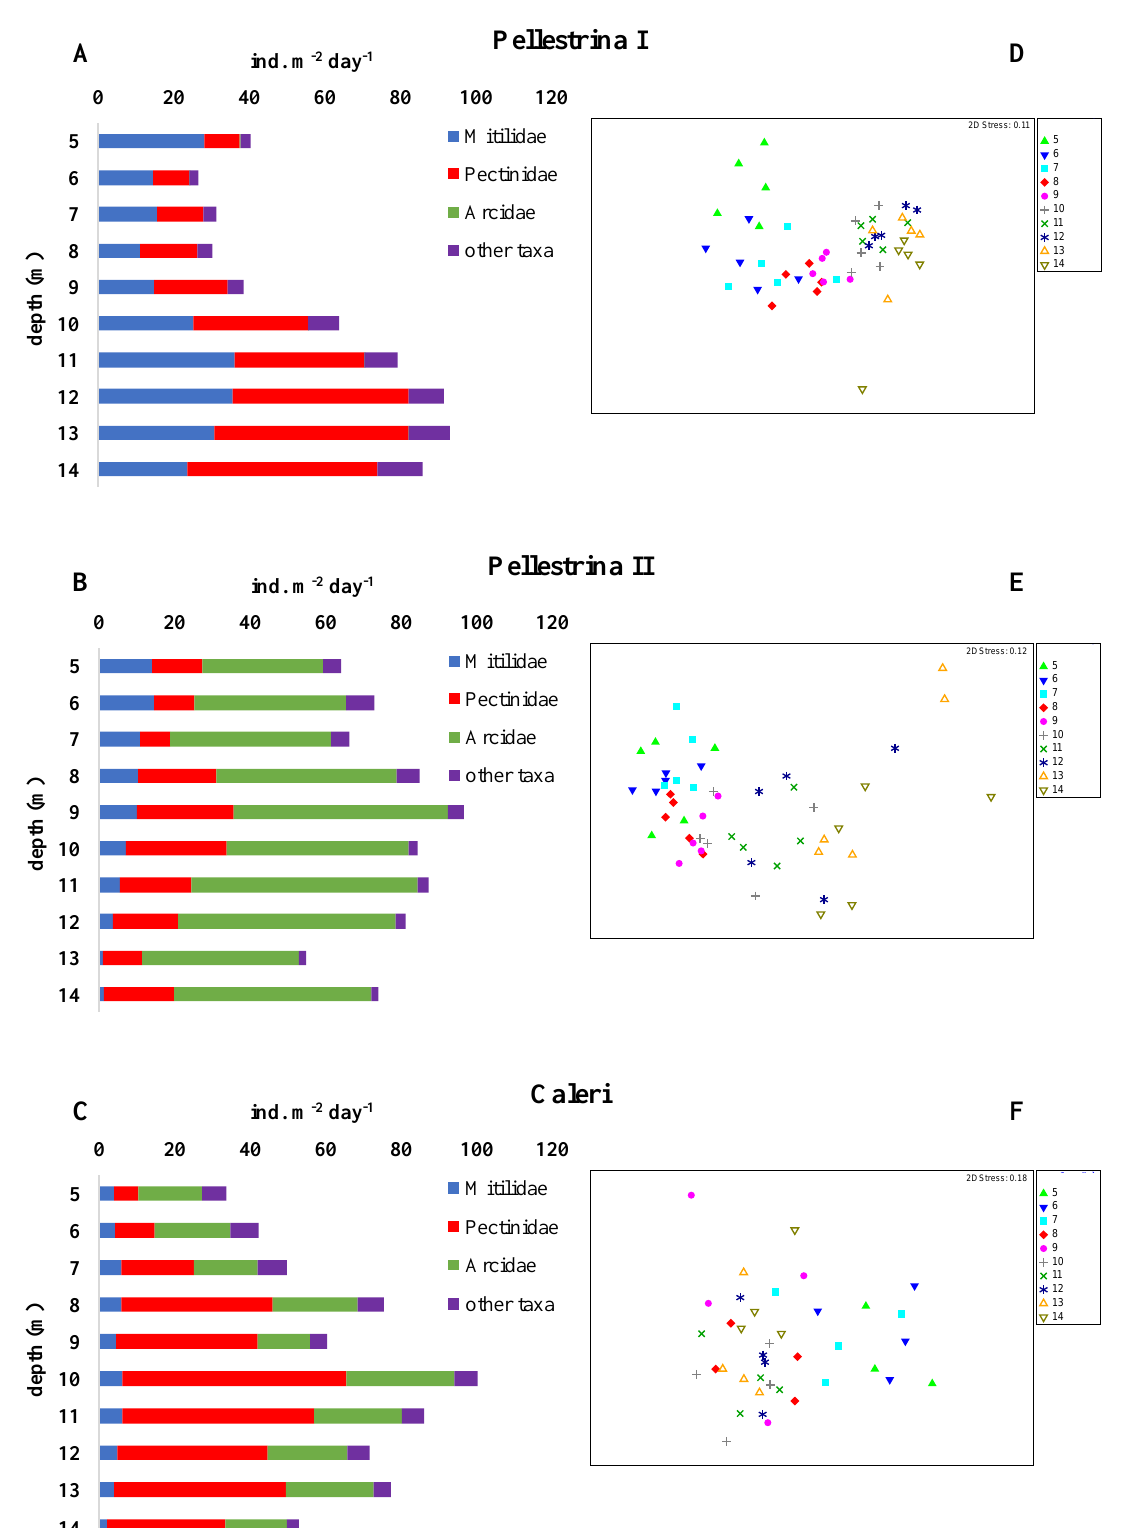
Figure 3. Settlement rate of the main bivalve families at different depths ( A – C ) and 2D-MDS plots of bivalve species composition similarities among depths ( D – F ) over the three sampling